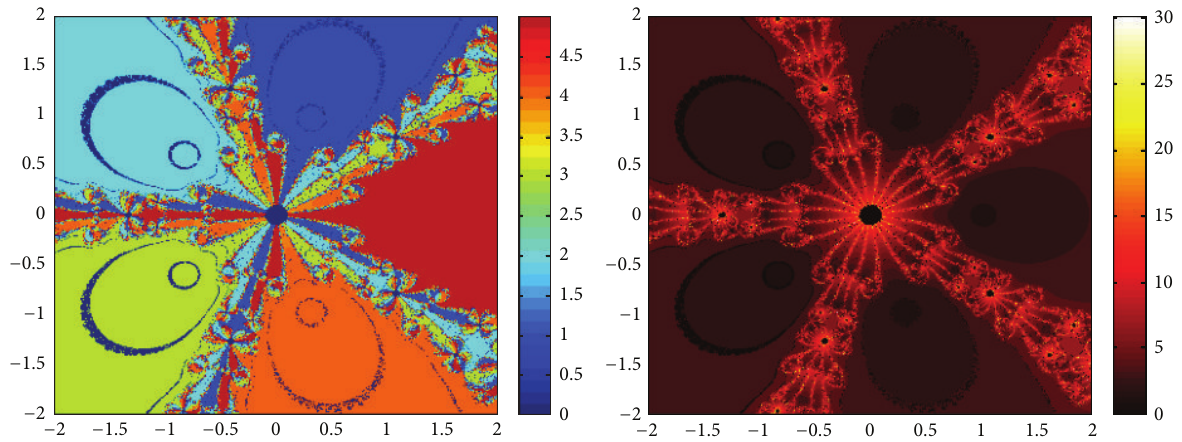
Figure 7: Basins of attraction of method (7) for 𝑝 5 (𝑥) .